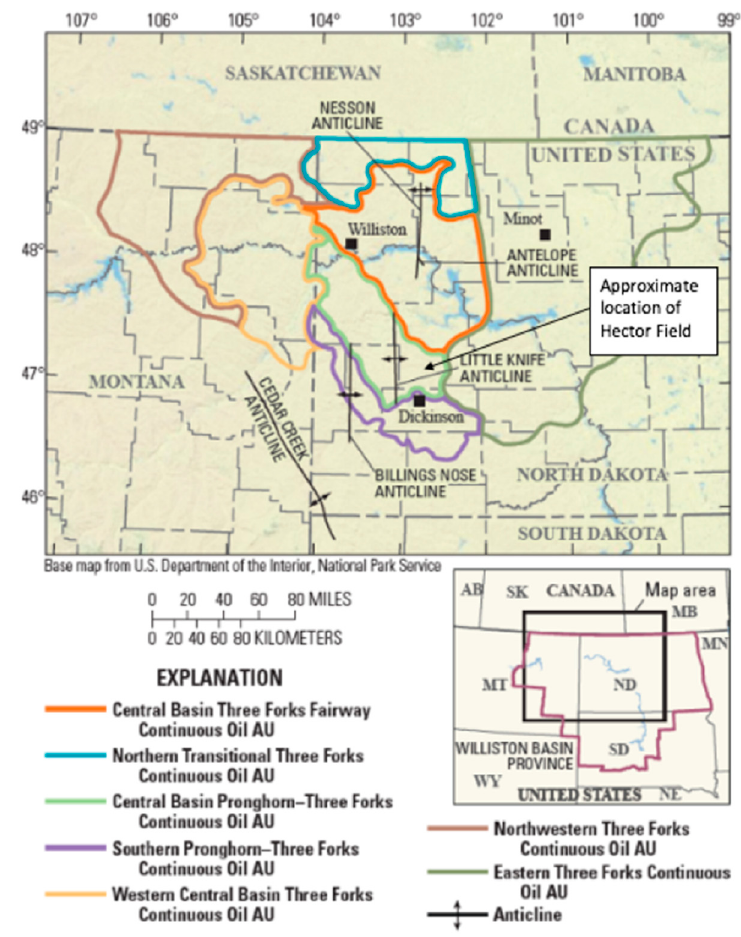
Figure 4. Location of Hector field in North Dakota [18] .